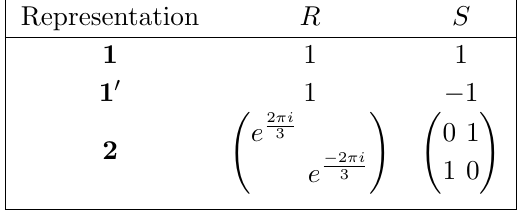
Table 14 . Representation matrices for D 3